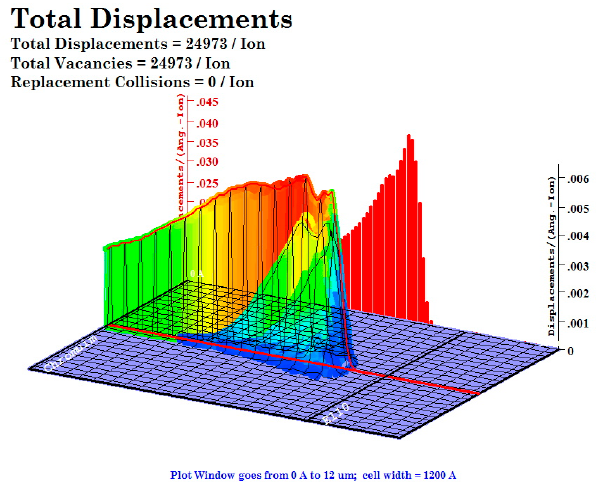
Figure 13. Damage caused by 120 MeV Rh in E110 alloy, coated with 9 µm thin film of Cr. The calculated maximum damage induced by 120 MeV palladium (Pd) in the E110 alloy and the corresponding protective chromium coating thickness required is illustrated in Figures 14 and 15. Again, the calculations show that a thin Cr film ~ 9 µm will be capable enough to protect the fuel cladding from the damage induced by highly energetic Pd recoil, and contains this damage accordingly.